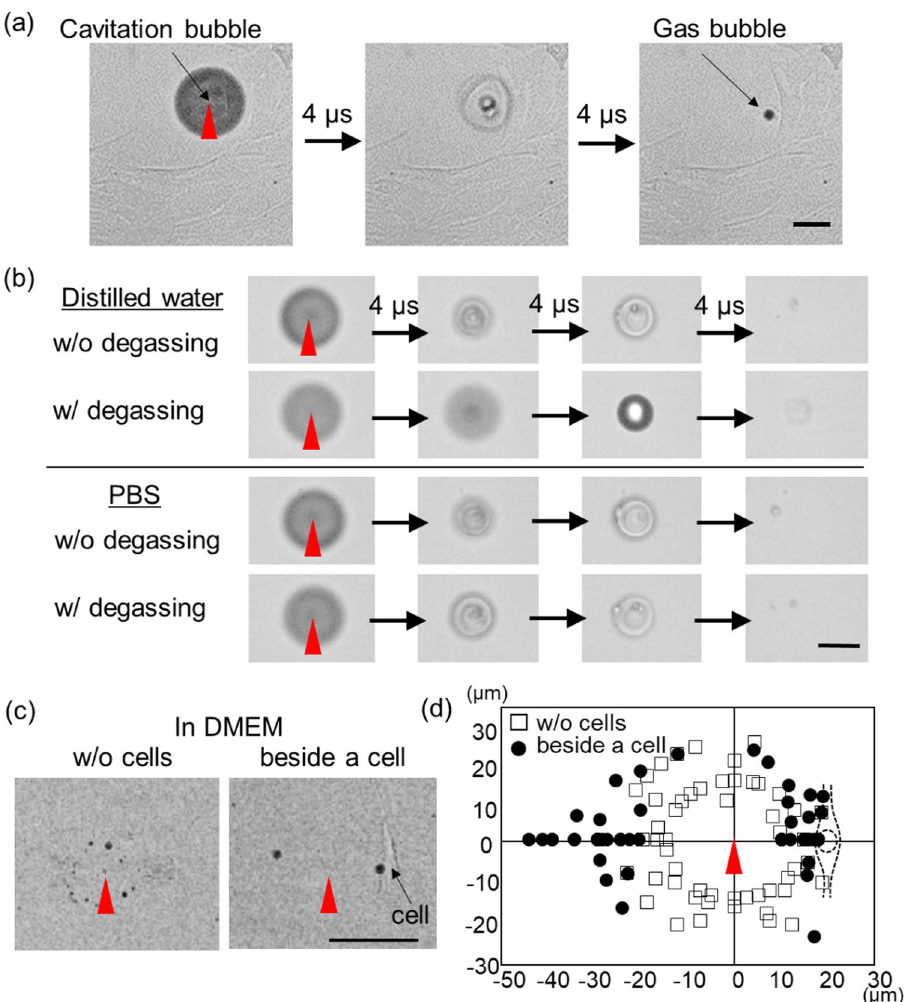
Figure 1. fs laser breakdown induced gas bubble generation observed by the high-speed camera. Single fs laser pulse with 300 nJ was used. ( a ) A series of high-speed transmission images of the gas bubble forming in DMEM at 4 μs interval. ( b ) Effects of the degassing on the gas bubble forming in distilled water and in PBS. ( c ) The high-speed transmission images of the gas bubble formation in DMEM without cells and beside cells. ( d ) A summary of the bubble remaining positions for without a cell and beside a cell in DMEM. The cell position relative to the laser focal point is also illustrated. The scale bars are 50 μm for all images. The red triangles indicate the laser focal